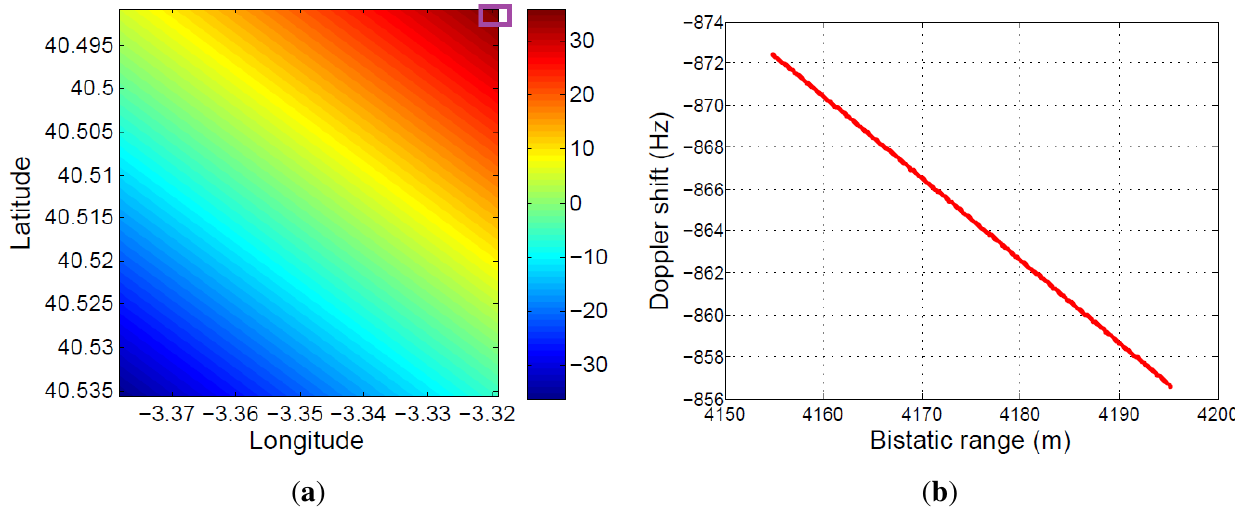
Figure 24. System geometry analysis assuming different TerraSAR-X orbital parameters (3 June 2015, 17:34:15): ( a ) total variation of the bistatic range during the acquisition